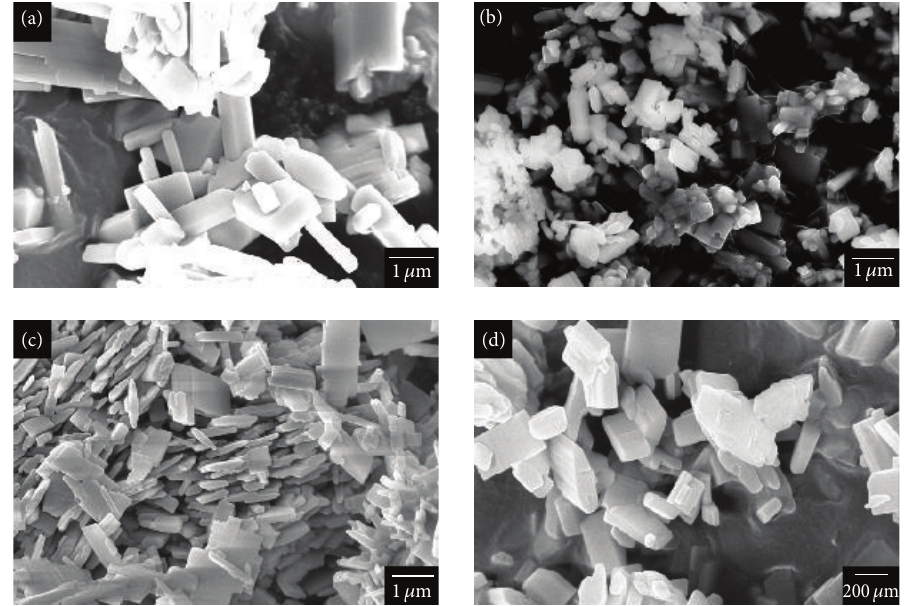
Figure 8: SEM images of LiMnPO 4 synthesized with various parameters: (a) 190 ∘ C [H 2 O]/[Mn] = 30 (sample B), (b) 190 ∘ C [H 2 O]/[Mn] = 15 (sample E), (c) 150 ∘ C [H 2 O]/[Mn] = 30 (sample F), and (d) 150 ∘ C [H 2 O]/[Mn] = 15 (sample